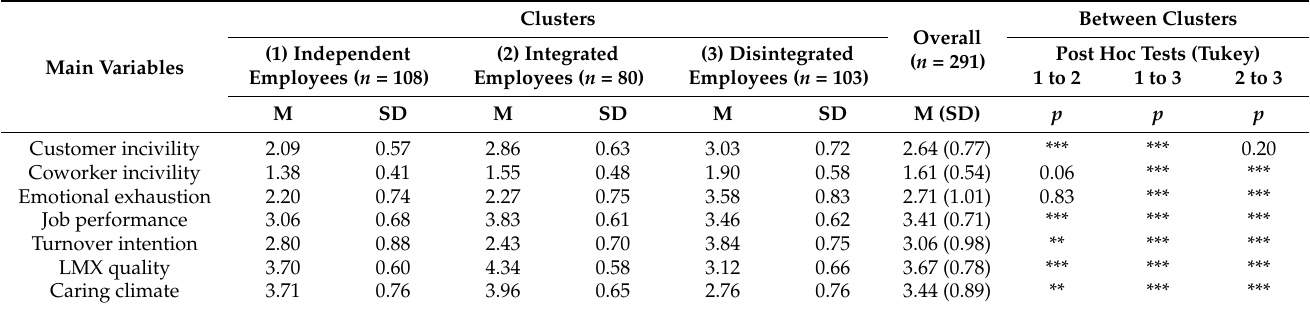
Table 5. Behavioral profiles of the three clusters and their